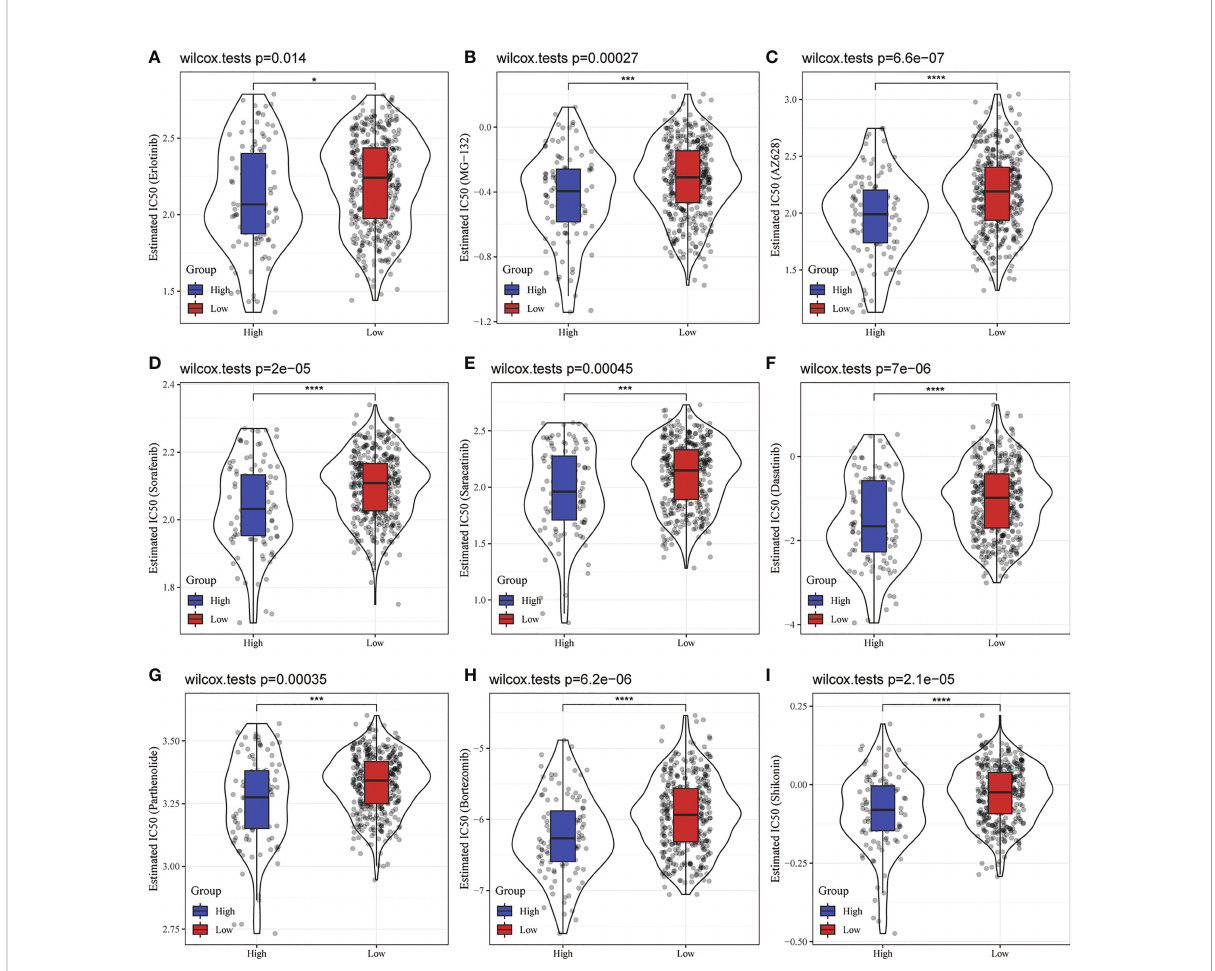
FIGURE 9 Comparison of targeted drug sensitivity in high CADM1-CADM1 group and low CADM1-CADM1 group. (****P < 0.0001, ***P < 0.001, *P < 0.05). (A) Comparison of the sensitivity of Erlotinib. (B) Comparison of the sensitivity of MG-132. (C) Comparison of the sensitivity of AZ628. (D) Comparison of the sensitivity of Sorafenib. (E) Comparison of the sensitivity of Saracatinib. (F) Comparison of the sensitivity of Dasatinib. (G) Comparison of the sensitivity of Parthenolide. (H) Comparison of the sensitivity of Bortezomib. (I) Comparison of the sensitivity of